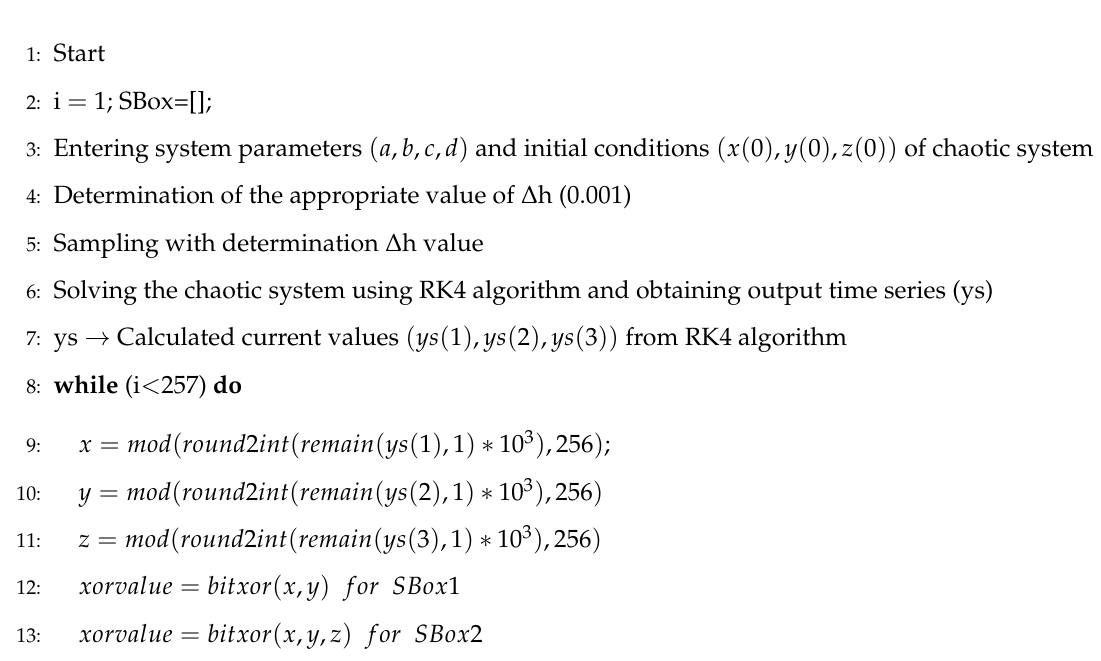
Algorithm 1 S-box generation algorithm pseudo